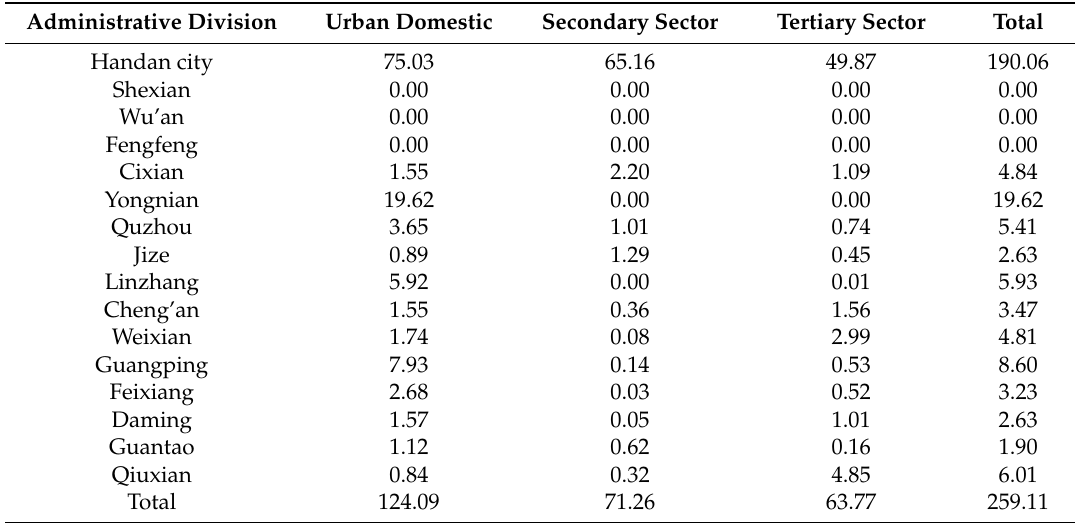
Table 7. Results for South to North transferred water allocated to every user (10 6 m 3